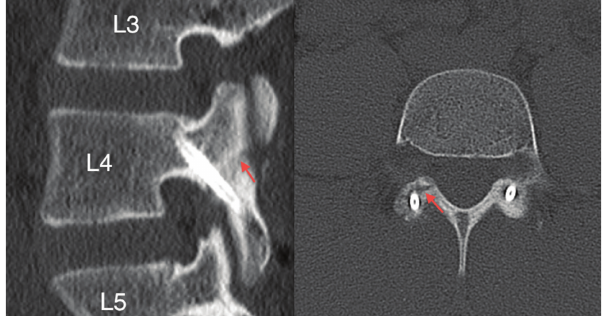
Figure 6: Three-month post-operative CT shows appropriate intraosseous screw placement with healing of the pars defect and no signs of